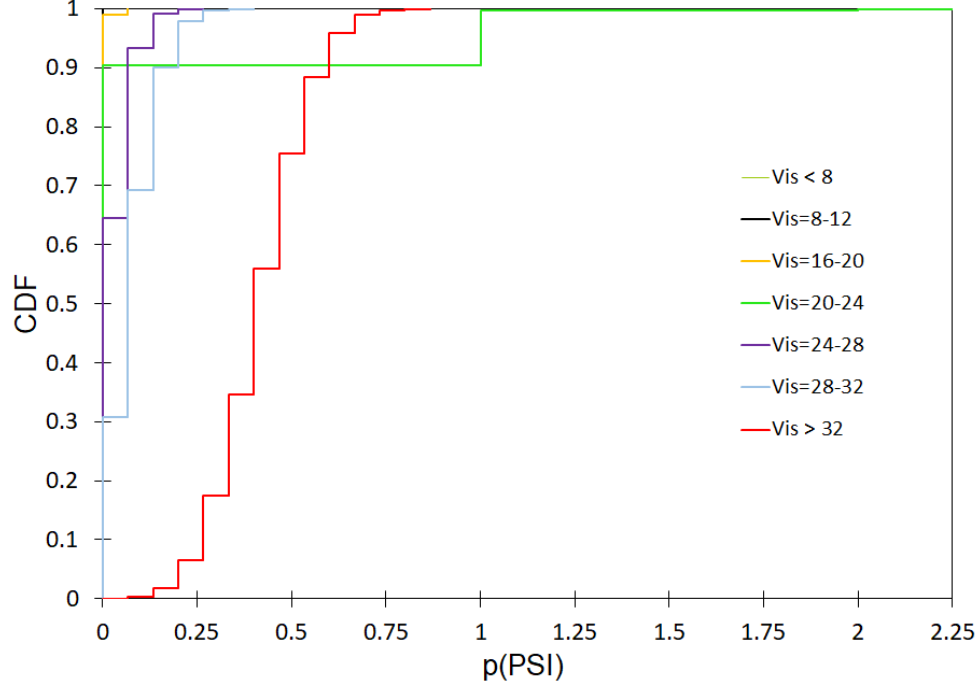
Figure A17. Effect of visibility on the incidence of low summer mortality for rainless days.